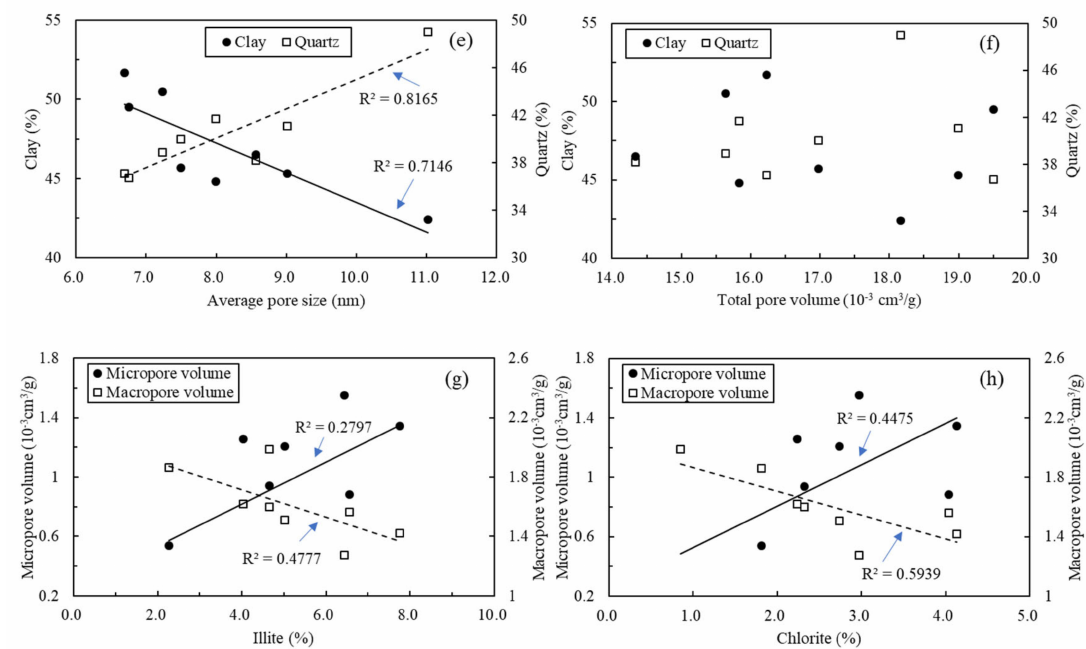
Figure 7. Plots of shale compositions versus nanopore structure parameters in the studied shale. ( a ) BET SA and APS versus TOC content, ( b ) PV versus TOC content, ( c ) PV versus R o , ( d ) BET SA versus clay and quartz content, ( e ) APS versus clay and quartz content, ( f ) PV versus clay and quartz content, ( g ) micropore volume and macropore volume versus illite content, ( h ) micropore volume and macropore volume versus Chlorite content.